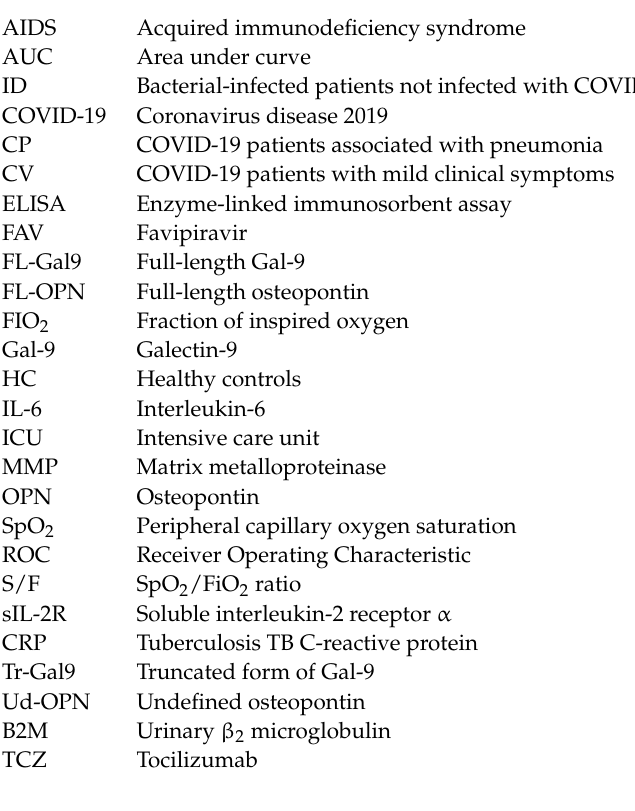
groups versus the HC group. Table S2: Statistical data of the ROC analysis of the CP group versus the CV group. Figure S1: Ratios of Tr-Gal9/FL-Gal9 (A) and Ud-OPN/FL-OPN (B) in the CV, CP, ID, and HC groups. Figure S2: Time course of inflammatory, coagulation, kidney and respiratory indicators during TCZ therapy in each patient. Figure S3: Time course of inflammatory, coagulation, kidney and respiratory indicators during therapy without